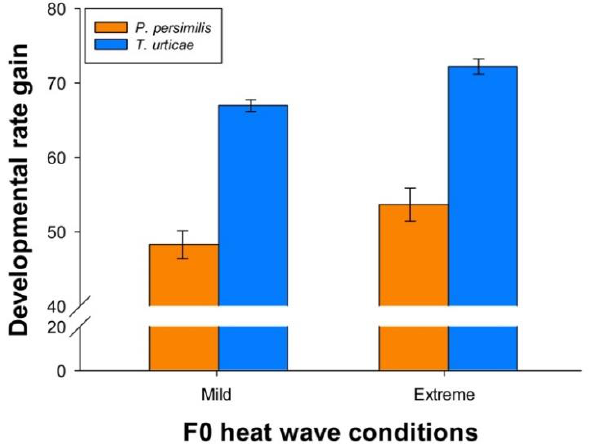
Figure 5. Heat wave effects during juvenile development on the leaf damage, age at maturity, and size at maturity of males ( A , C , E ) and females ( B , D , F ) of the prey T. urticae . The circles illustrate the